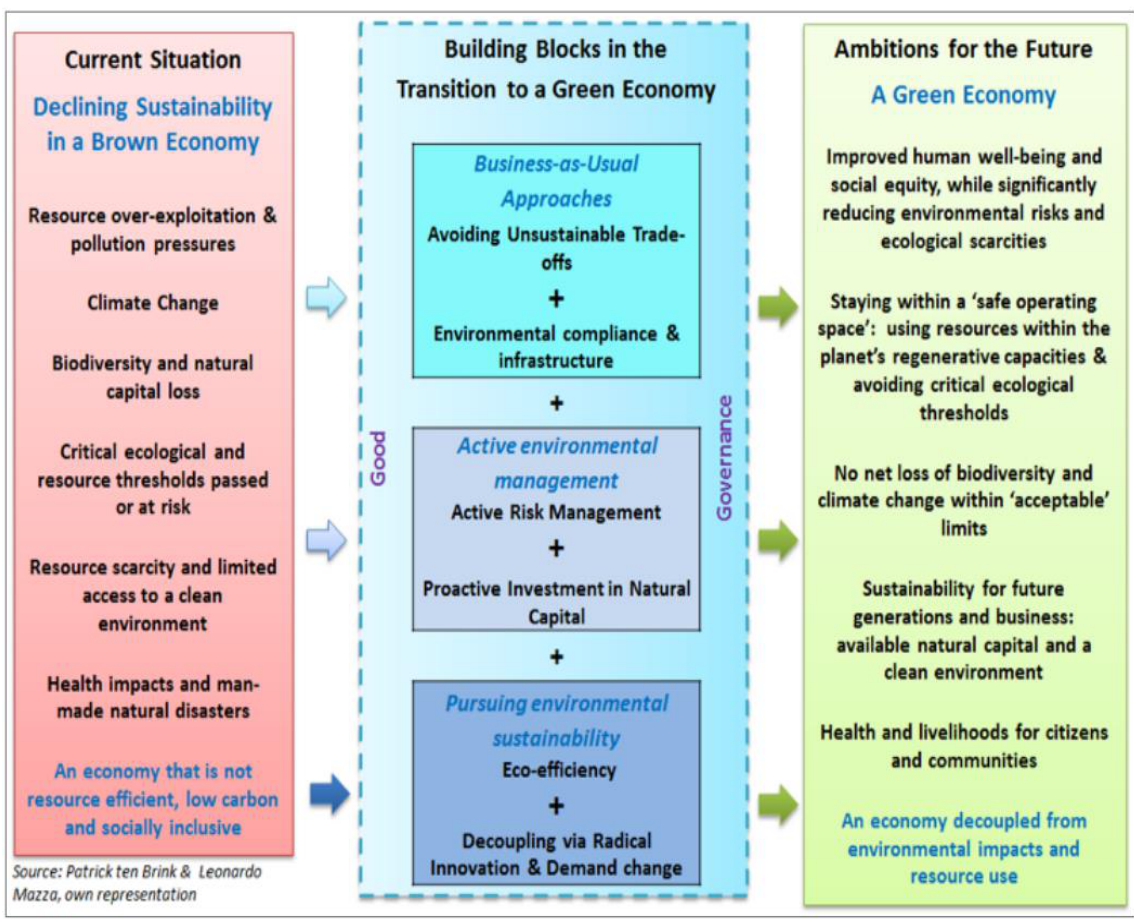
Figure 3: The key components and instruments to enable ease of transition to a green economy